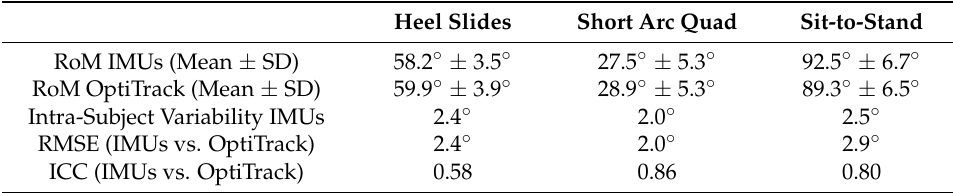
Table 1. Data from IMUs and OptiTrack system demonstrating the accuracy and